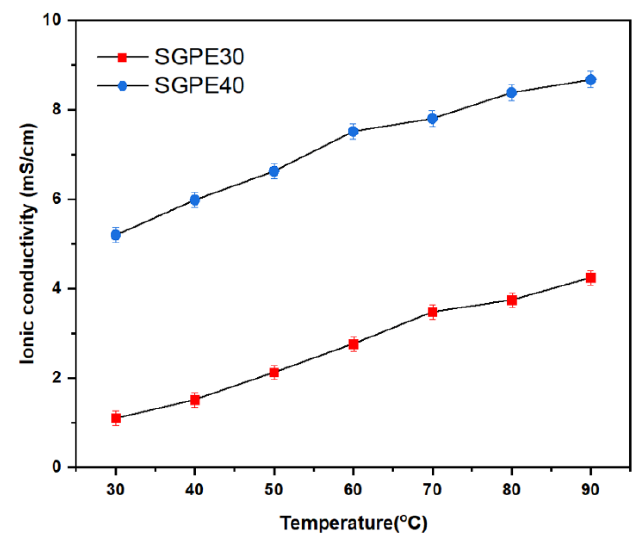
Figure 8. Nyquist plots of ( a ) SGPE30 and ( b ) SGPE40.